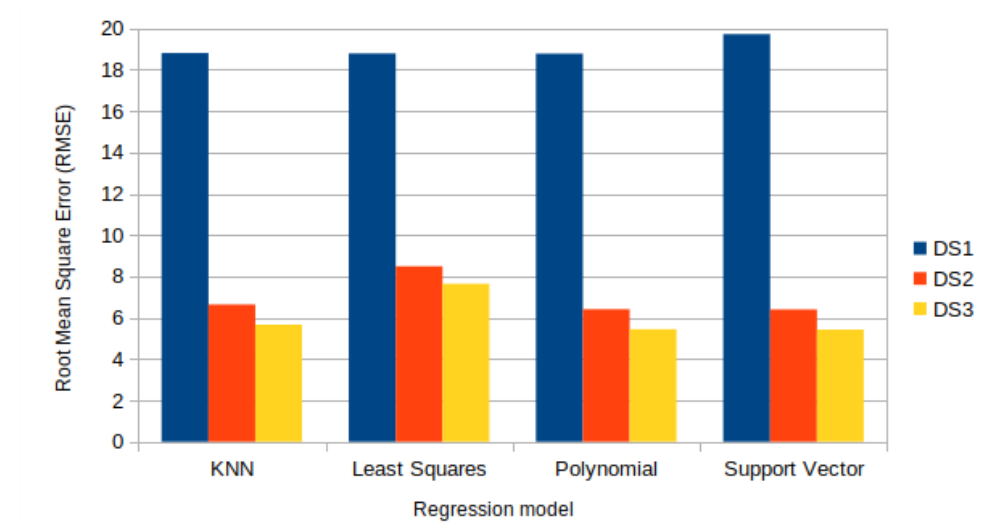
Figure 6. Comparison of the regression models used in [50] with datasets DS1 (without any process- ing), DS2 (after aggregation and preprocessing), and DS3 (after normalization with weight factors). The error measure is the Root Mean Square Error